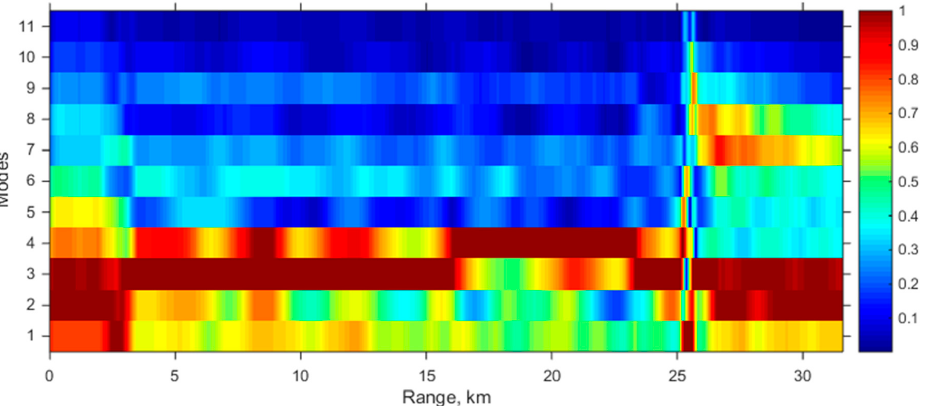
Figure 13. Modal amplitudes C m ( r ) for the waveguide without the soliton. In area of 25 km there is area of steep slope between shallow and deep parts of acoustic track.